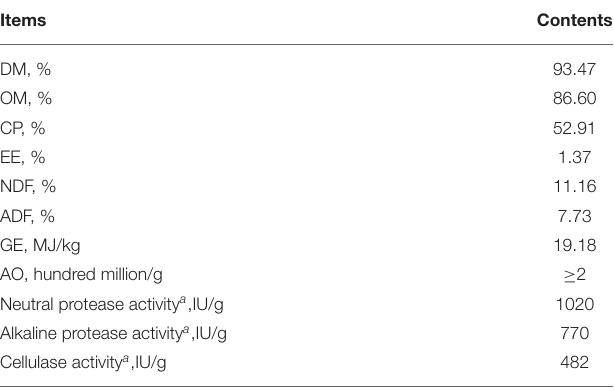
TABLE 2 | Nutrients and active components of Aspergillus oryzae culture (DM